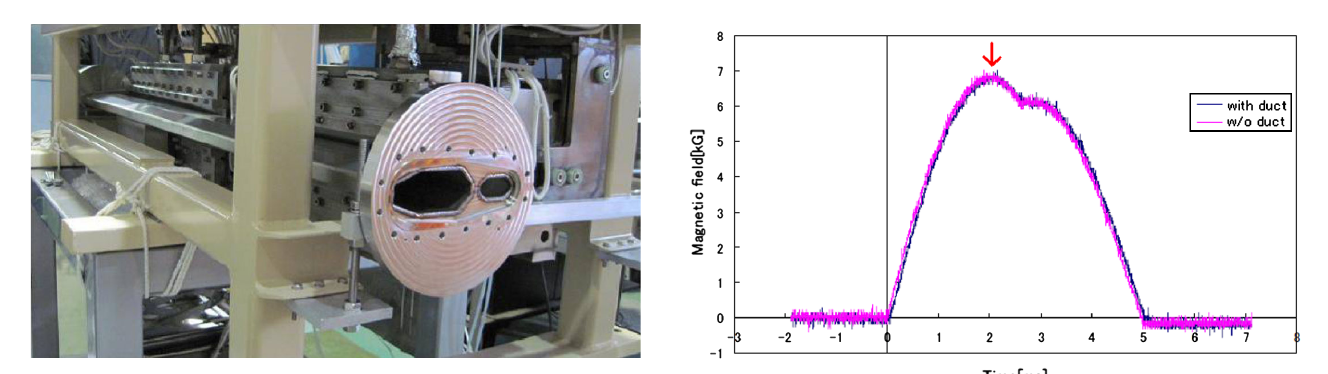
FIG. 24. Time profile of the septum magnetic fields. The arrow indicates the extraction